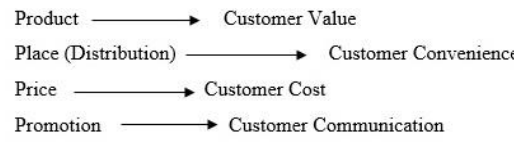
Figure 1. The Equivalents of 4P Elements in the 4C Source: Garda, B. (2016). Bütünleşik Pazarlama İletişimi: Konya İli Örneği. Selçuk Üniversitesi Sosyal Bilimler Meslek Yüksek Okulu Dergisi, 19,